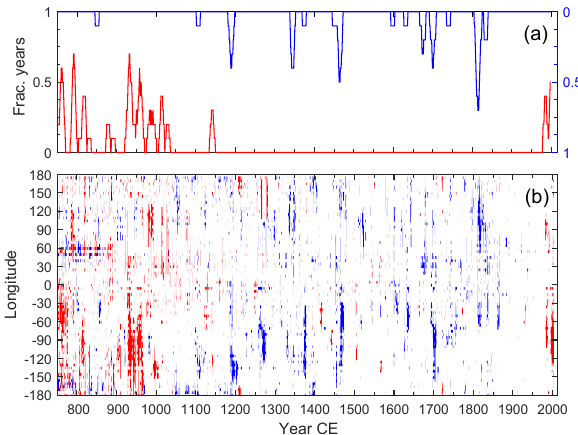
Figure 9. (a) Fraction of potentially warmest or coldest years per decade with respect to time. (b) Occurrence of statistically signif- icant, potentially warmest (red) and coldest (blue) years over the period 750–2002CE in different sectors of the Arctic